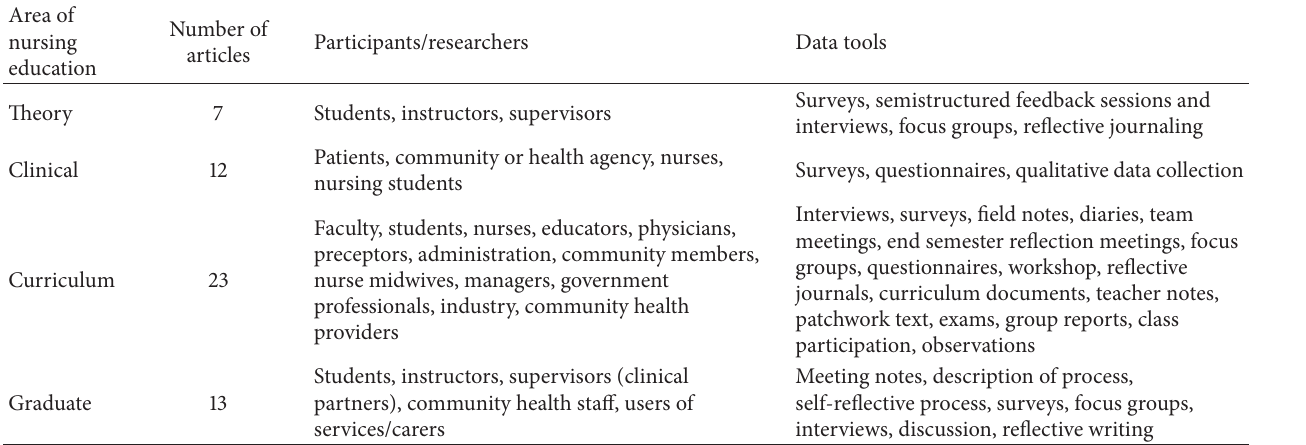
Table 1: Overview of review articles’ focus, participants/researchers, and data collection